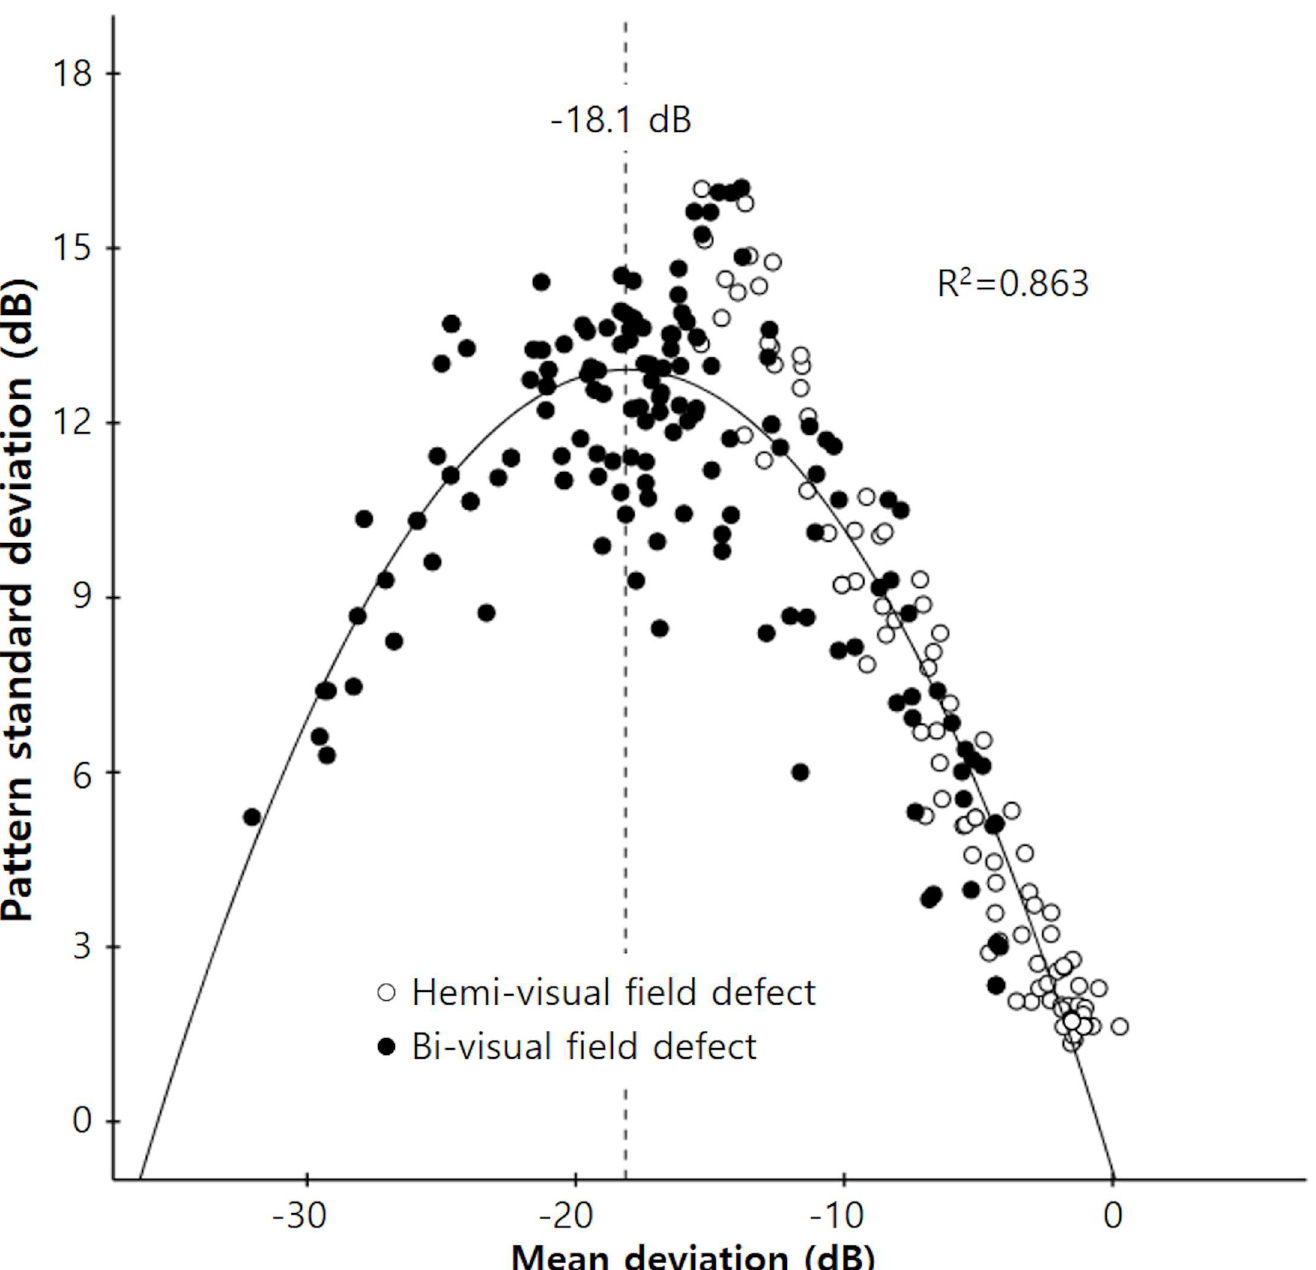
Fig 2. Scatterplot showing the relationship between mean deviation (MD) and pattern standarddeviation (PSD). PSD increasedas MD decreased from 0 dB to − 18.1dB, andPSD then decreasedas MD deteriorated further. Correlations werecalculated usingthe followingequation:Y = − 0.817+ 1.523X − 0.042X 2 (r 2 = 0.863, P < 0.001).In the hemi-optic neuropathygroup,in whichMD valueswerelocalizedto the right side, the relationship betweenMD and PSD was more linearin distribution,the correlationcoefficient (r) was − 0.973,andthe linearregression coefficient ( β )was − 0.965( P <